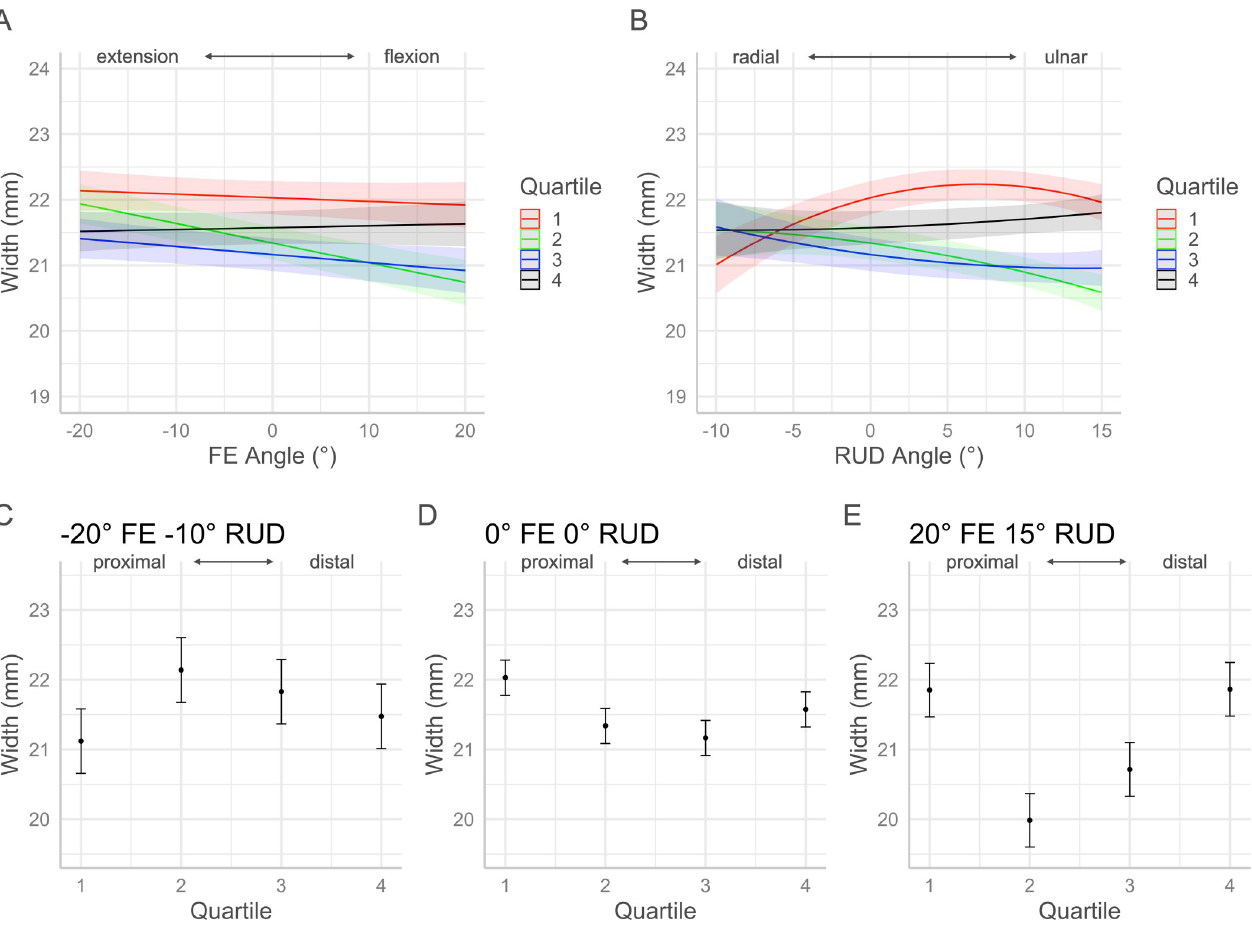
Fig 7. Effects of FE and RUD wrist postures on the mean carpal tunnel width within each quartile. Panel A shows the effects of varying FE angle with 0˚ RUD. Panel B shows the effect of varying RUD angle with 0˚ FE. Panels C/D/E show the predicted values with 95% confidence intervals for each quartile for an extended radially deviated posture (panel C), a neutral posture (panel D), and a flexed and ulnarly deviated posture (panel E).